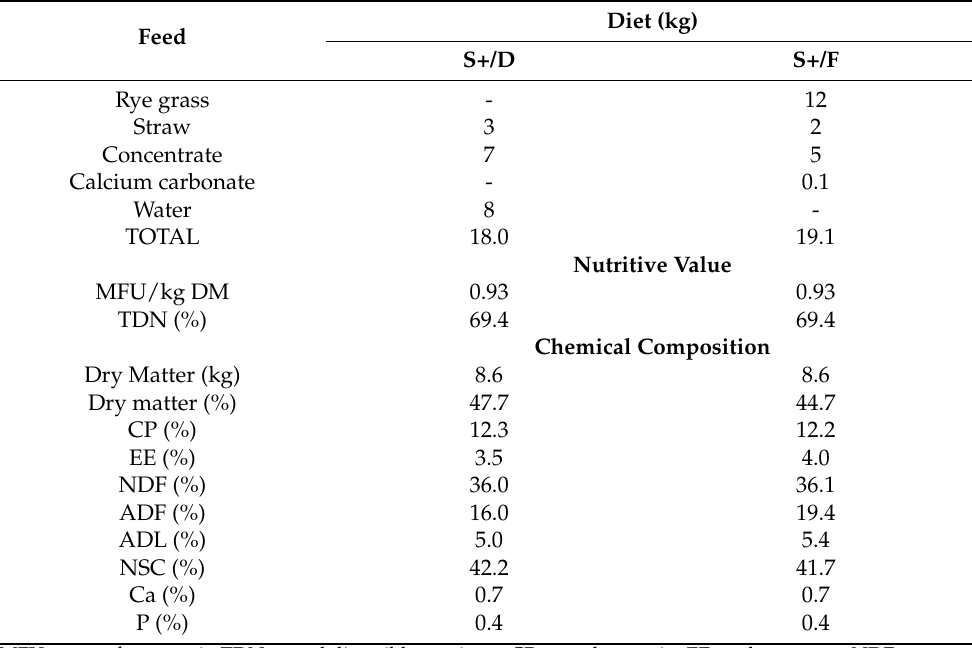
Table 2. Feed (kg) and chemical composition (% of dry matter, DM) of the diet in buffaloes with (S+/F) or without (S+/D) rye grass inclusion. Feed